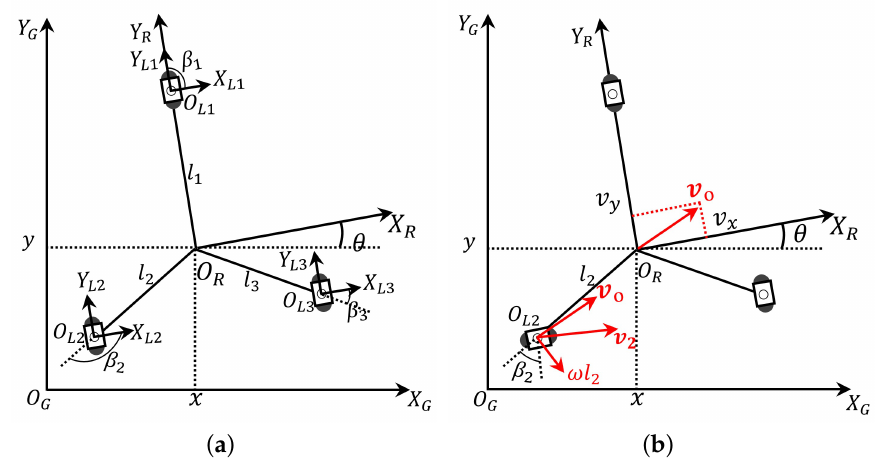
Figure 5. Kinematics reference frame. ( a ) Three-wheeled omnidirectional mobile chassis reference frame. ( b ) The velocity of wheel set